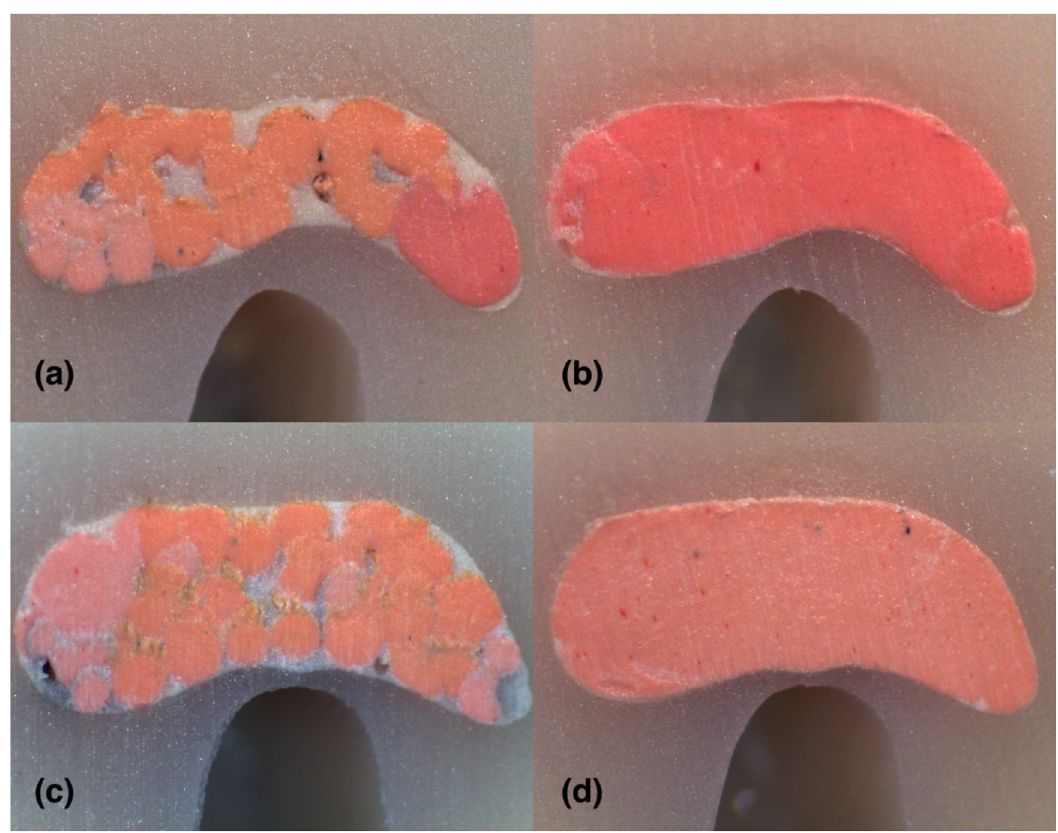
Fig 5. Stereomicroscope images of 4 mm sections instrumented with Hyflex EDM: (A) LC (B) CW; Stereomicroscope images of 4 mm sections instrumented with Reciproc Blue: (C) LC (D) CW showing the resin thickness difference between shaping systems in groove area of